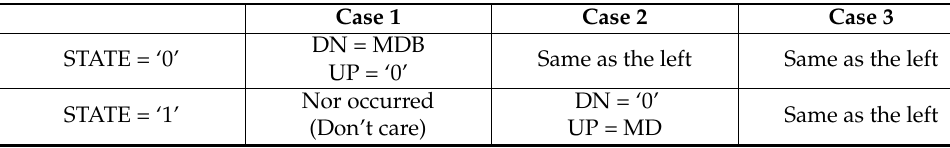
Table 1. Logic table for UP/DB pulse generation.